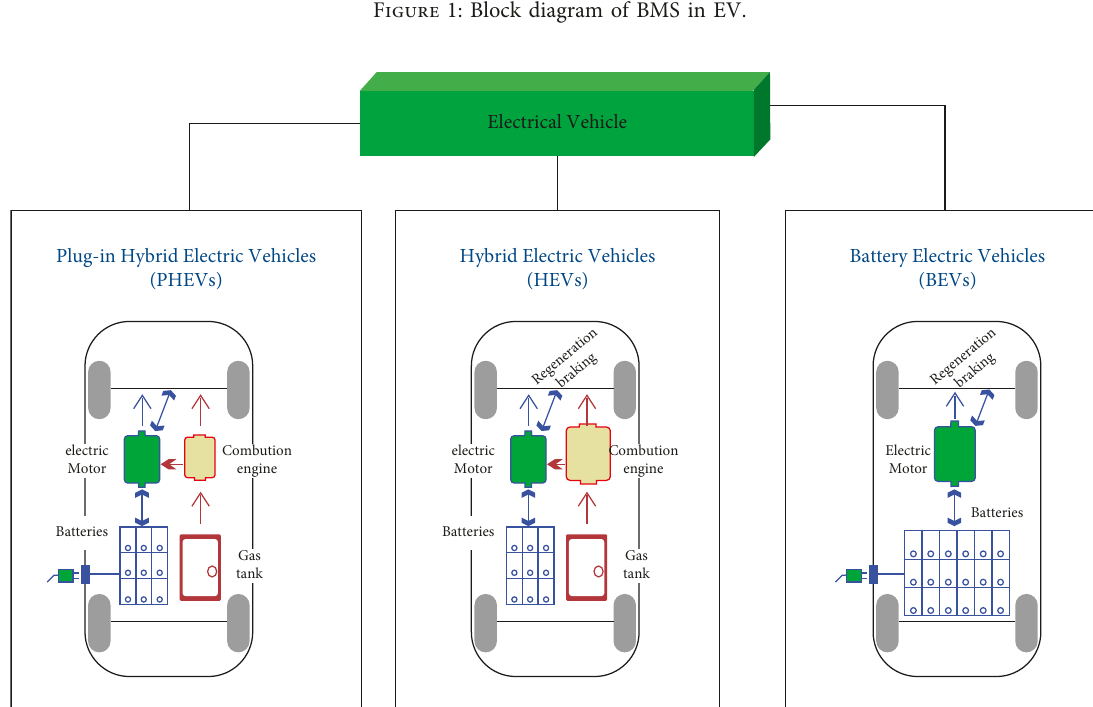
Figure 2: Types of electrical